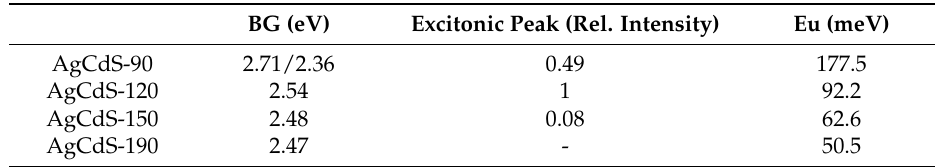
Table 4. Band gap, relative intensity of the excitonic peak areas and Urbach energy (Eu) of AgCdS-T photocatalysts from UV–vis